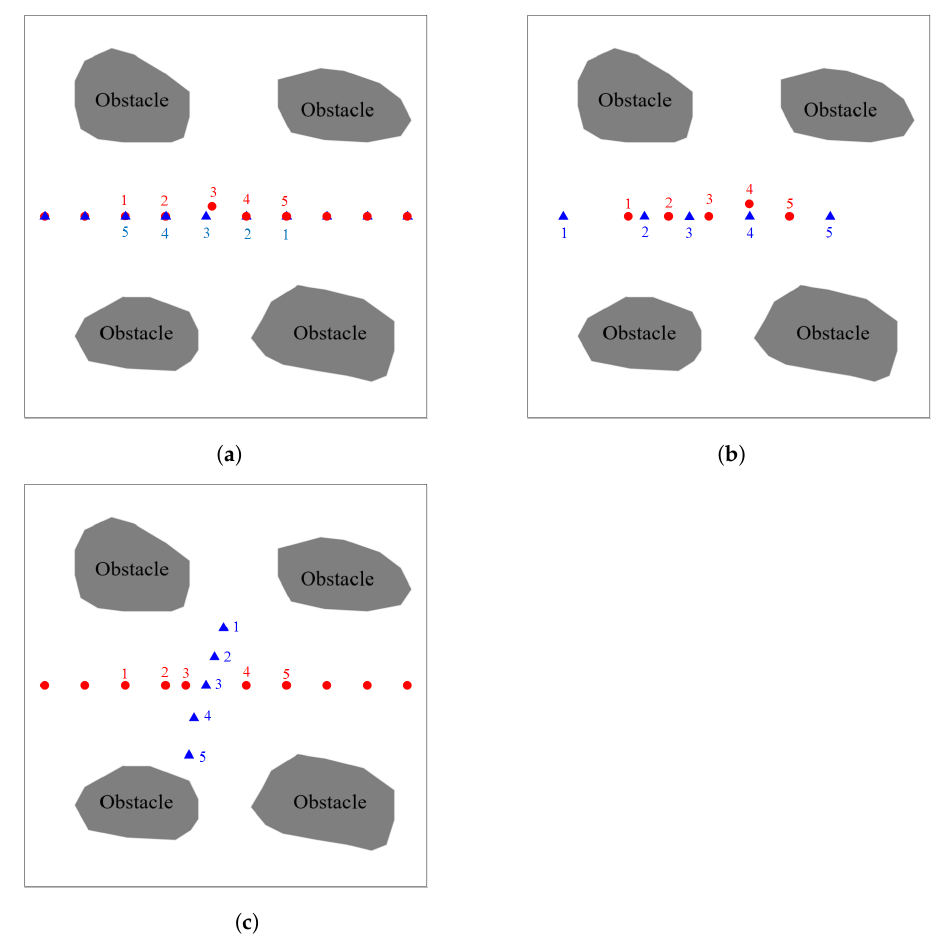
Figure 20. Dynamic flight obstacles are represented as blue triangles, the red circle is the UAV, and the number of the corresponding color is the coordinate point of the corresponding time. ( a , b ) show the local path adjustment for the opposite and codirectional obstacles, respectively. ( c ) shows the deceleration strategy of the